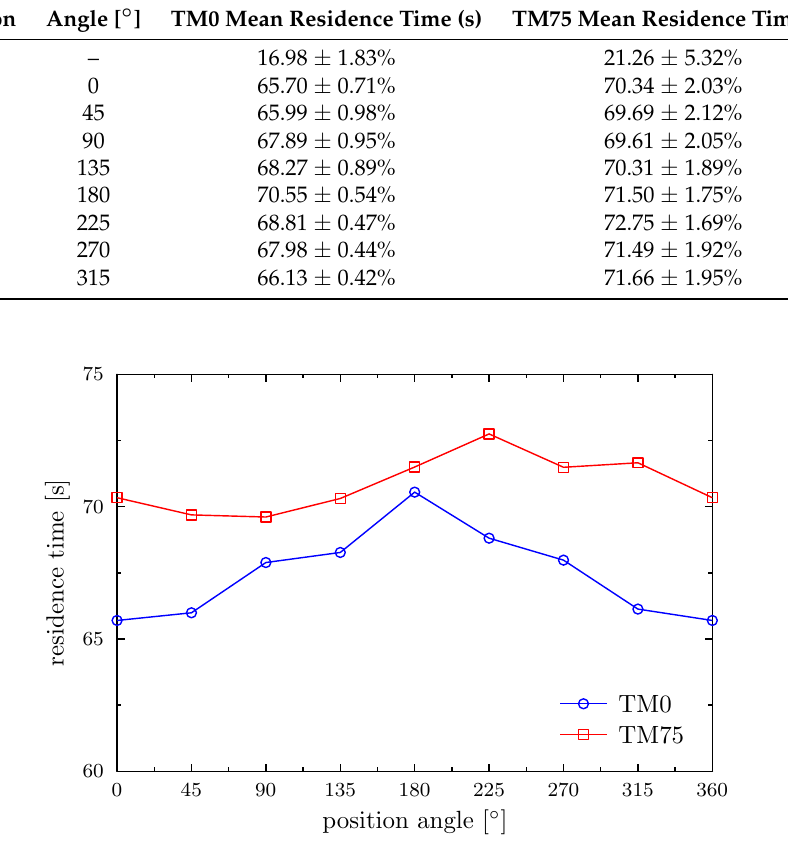
Figure 10. Dependency of the mean residence time with respect to the position angle (see Figure 11 on the left) along the perimeter of circle with 3/4 of the vessel radius. The inlet flow rate used to obtain these data in CFD simulations was 0.5 L/s.